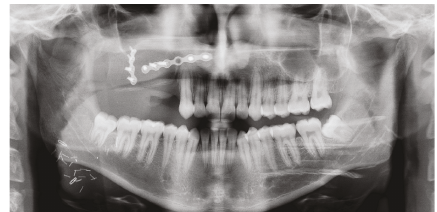
Figure 6: Panoramic X-ray after reconstruction by FRF.